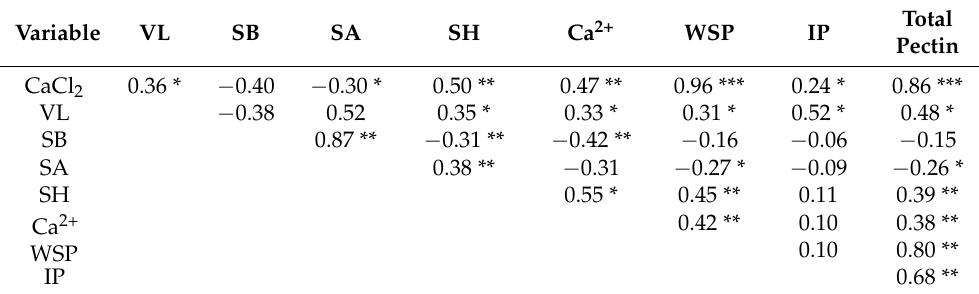
Table 4. Correlation between variables of flower quality trait of cut gerbera ‘Harmony’ treated with preharvest CaCl 2